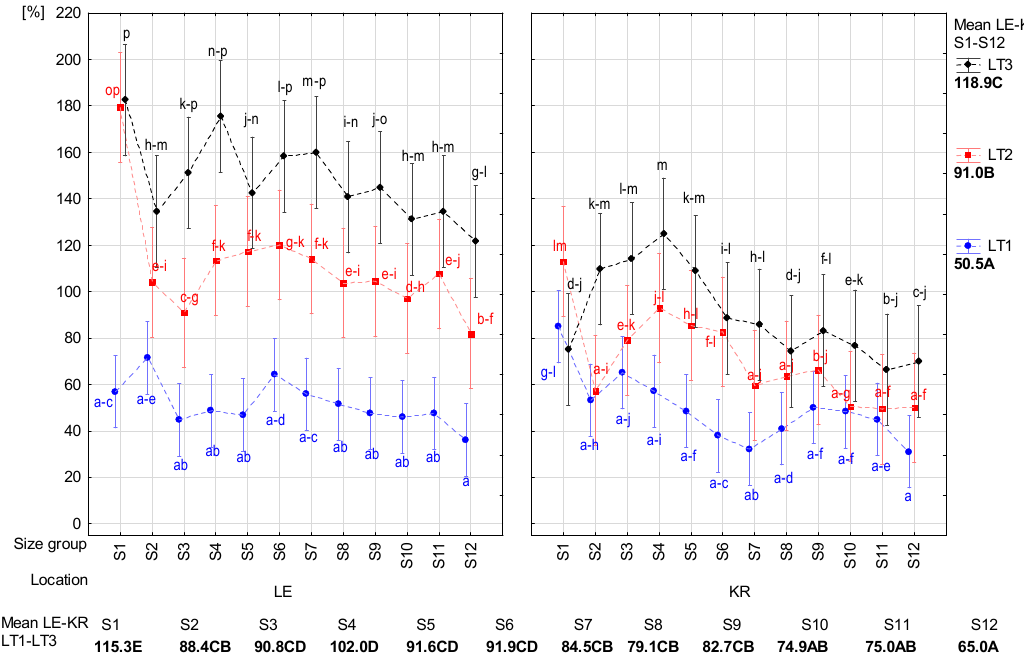
Figure 11. Effect of size group and lifting term on bulb weight increase (WI) indicator (%) for Lednice (LE) and Krakow (KR) locations. Mean values with different small letter within the location (LE or KR) as well as mean values with different large letter are significantly different according to Duncan’s multiple range test at p ≤ 0.05. For treatments description, see 2.1.–2.4, Materials and Methods sections.